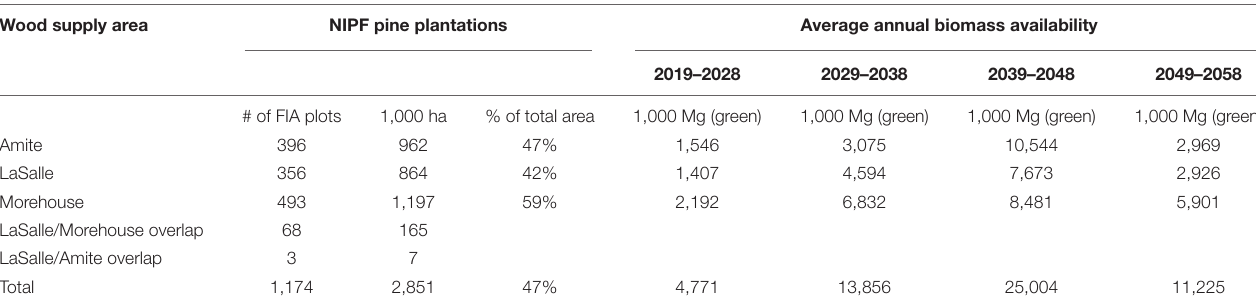
TABLE 3 | Potential pellet feedstock supply (and FIA plot coverage) for NIPF pine plantations by wood supply area. Wood supply